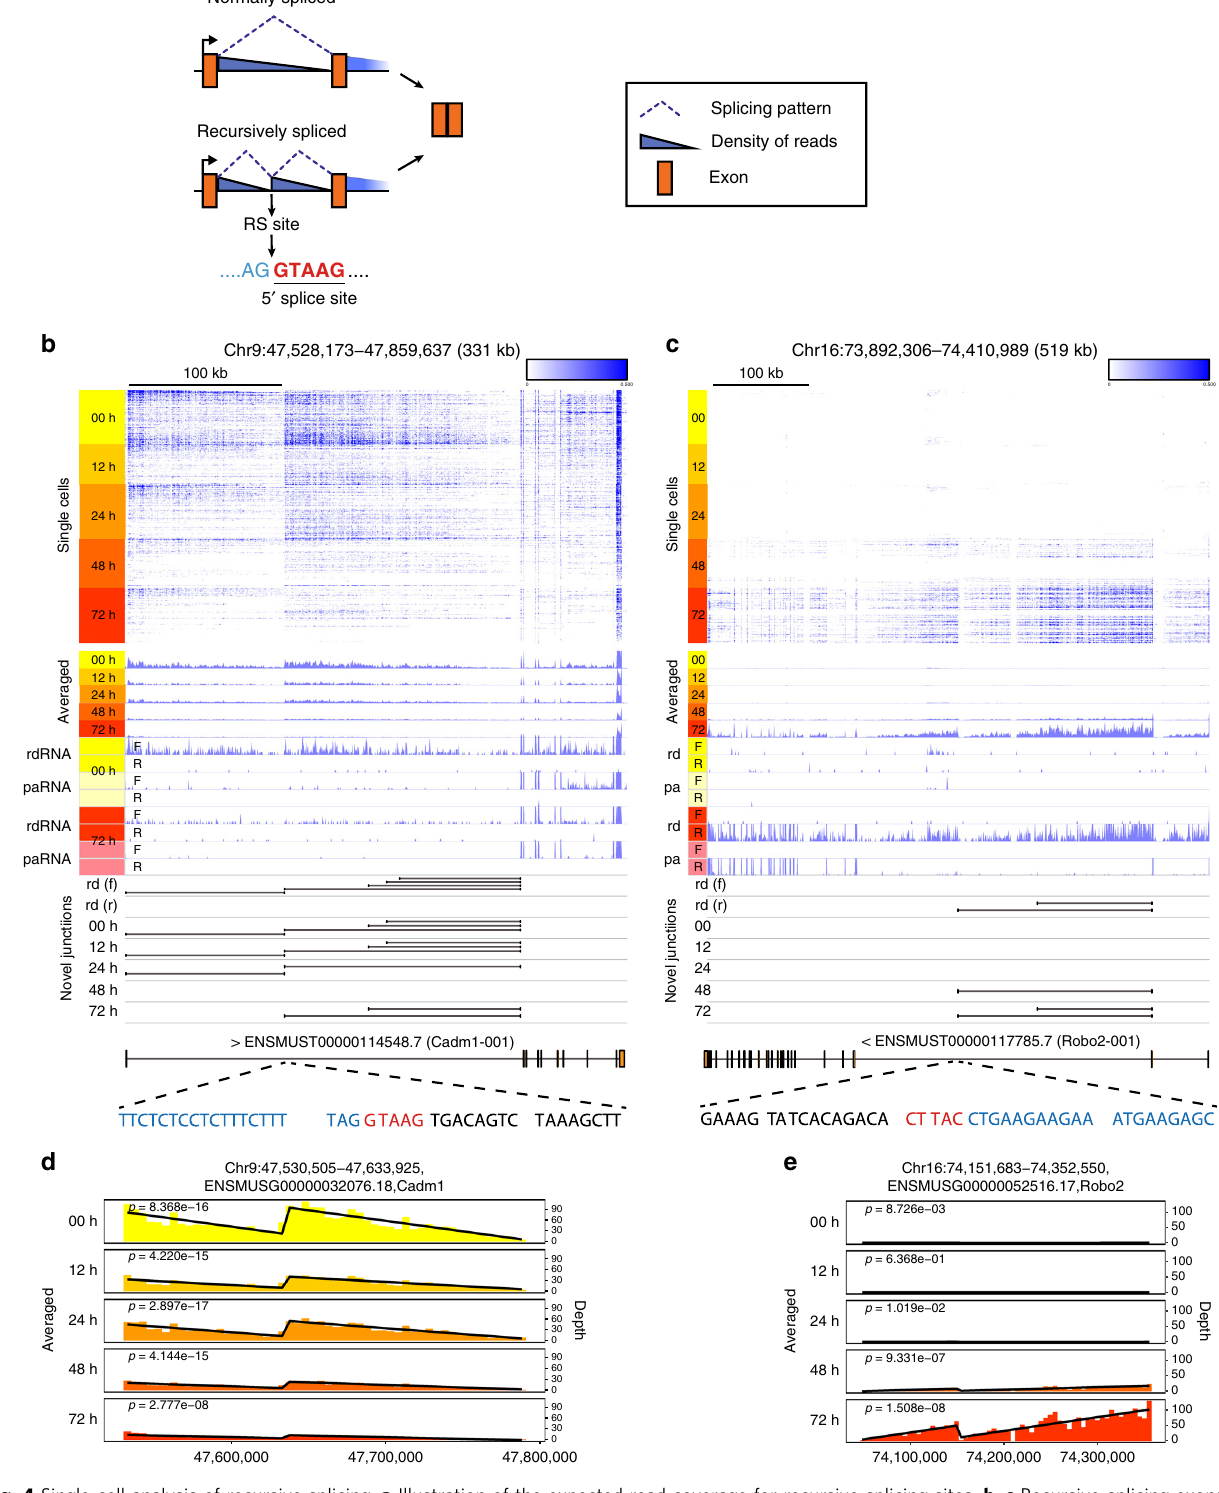
Fig. 4 Single-cell analysis of recursive splicing. a Illustration of the expected read coverage for recursive-splicing sites. b , c Recursive-splicing exons observed by RamDA-seq in Cadm1 ( b ) and Robo2 ( c ). The upper heat maps represent the RamDA-seq read coverage for each cell. The middle tracks represent the averaged RamDA-seq coverage for each sampling time point. The lower tracks represent the read coverage of rdRNA-seq (rd) and paRNA- seq (pa) on forward (f) and reverse (r) strands at 0 and 72 h. Novel splice junctions observed by rdRNA-seq (rd) on forward (f) and reverse (r) strands and RamDA-seq are also shown. Gene models and nucleotide sequences around recursive-splicing sites are shown at the bottom. The region upstream (blue) of the 5 ′ splice motif (red) has been excised to reconstitute the 5 ′ splice site. d , e The summed normalized read coverage of RamDA-seq for each time point in the 5-kb bin (bars) and the fi tted linear regression models (black lines) in Cadm1 ( d ) and Robo2 ( e ). The p -values of F-tests are